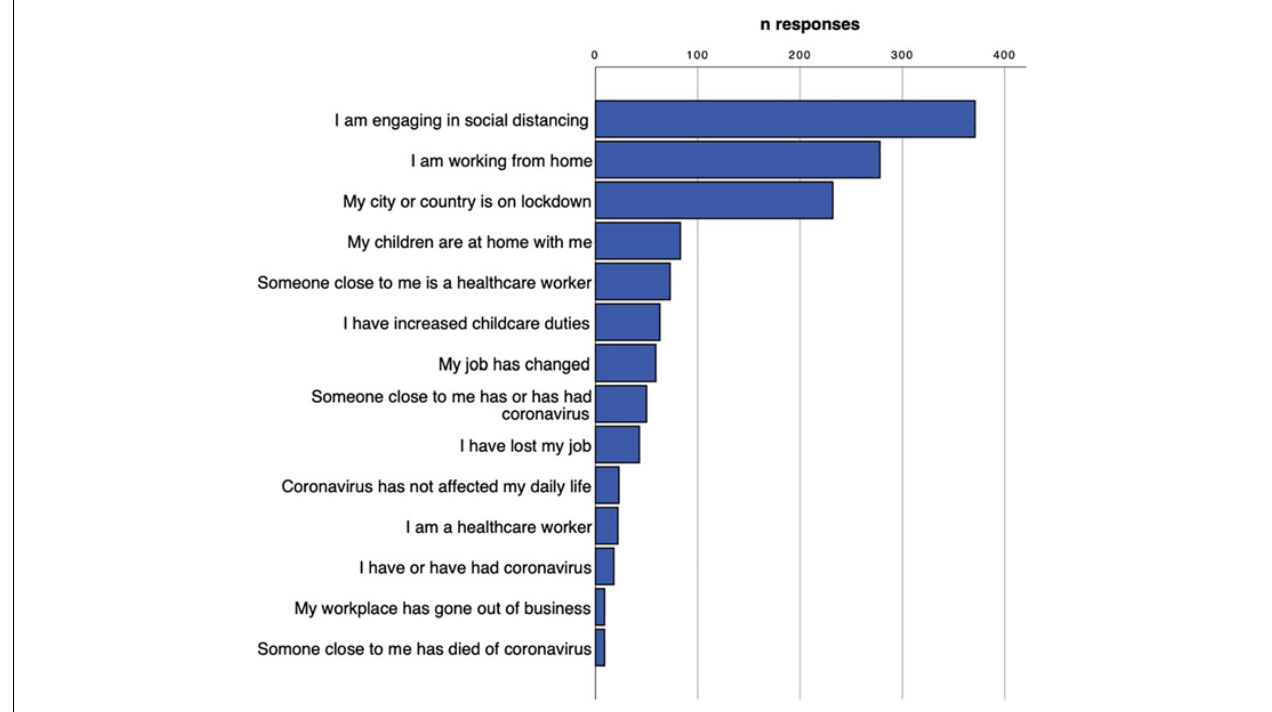
FIGURE 1 | Reported daily living situation of participants as relates to the coronavirus pandemic.